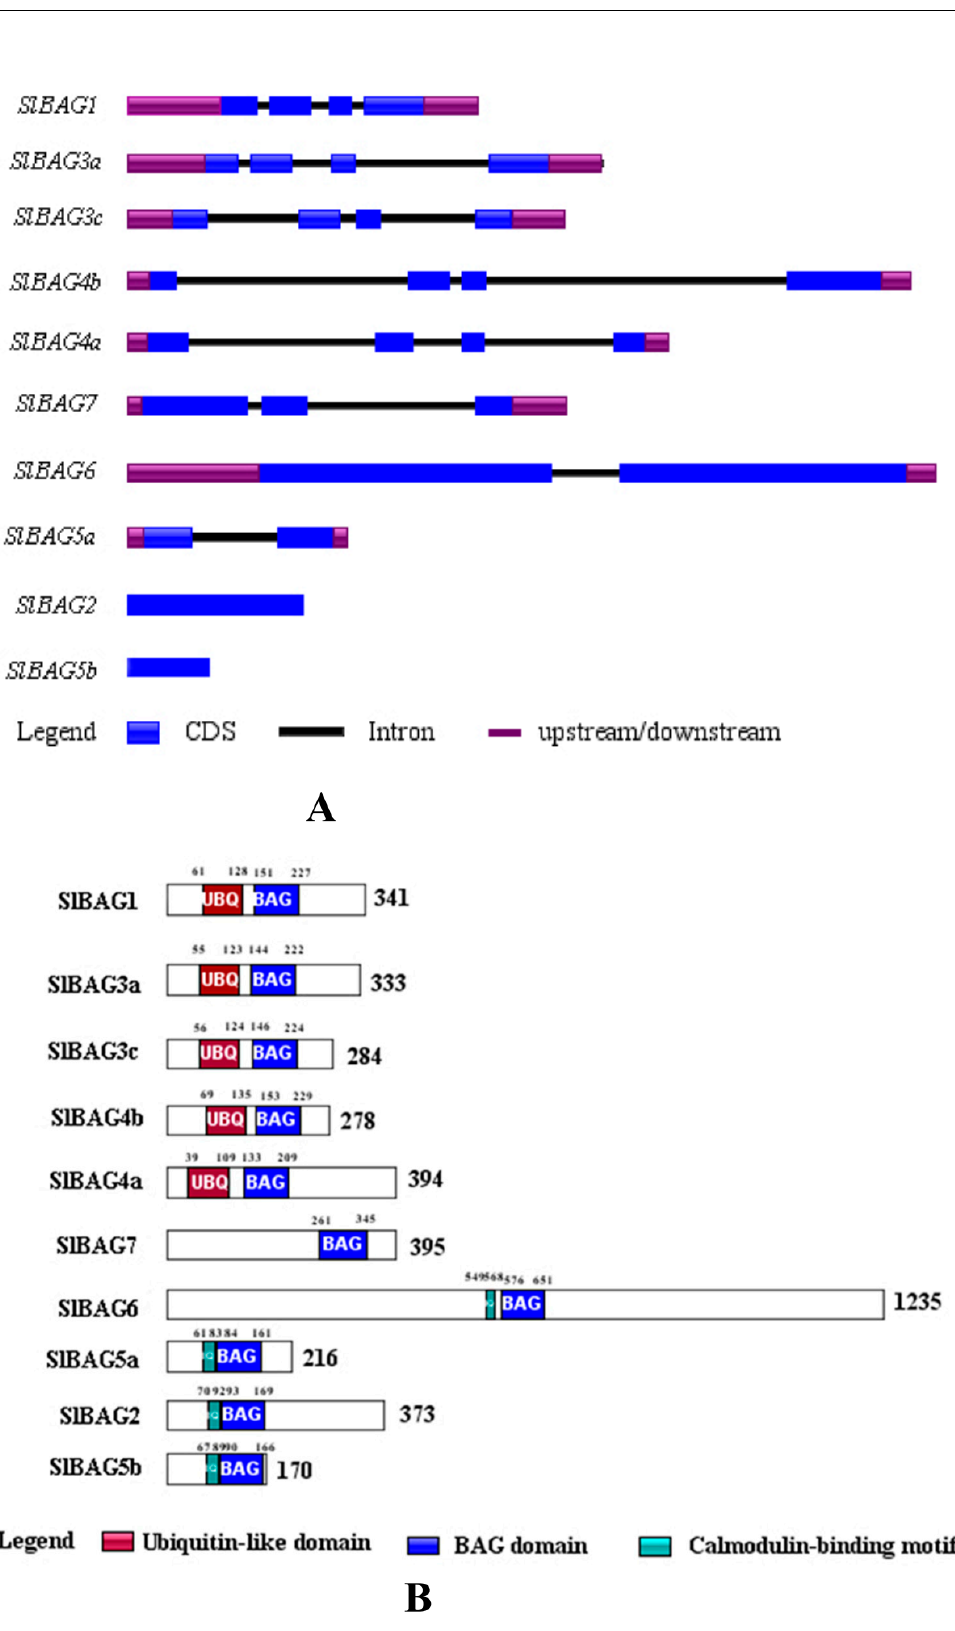
Figure 1. Gene structure and conserved domains of the tomato BAG genes. ( A ): Gene structure map. The black lines represent introns. The blue rectangles represent the CDS region. The purple rectangles represent the upstream/downstream regions; ( B ): conserved domain map. Numbers indicate the number of amino acids. UBQ represents the ubiquitin-like domain. IQ represents the Calmodulin-binding